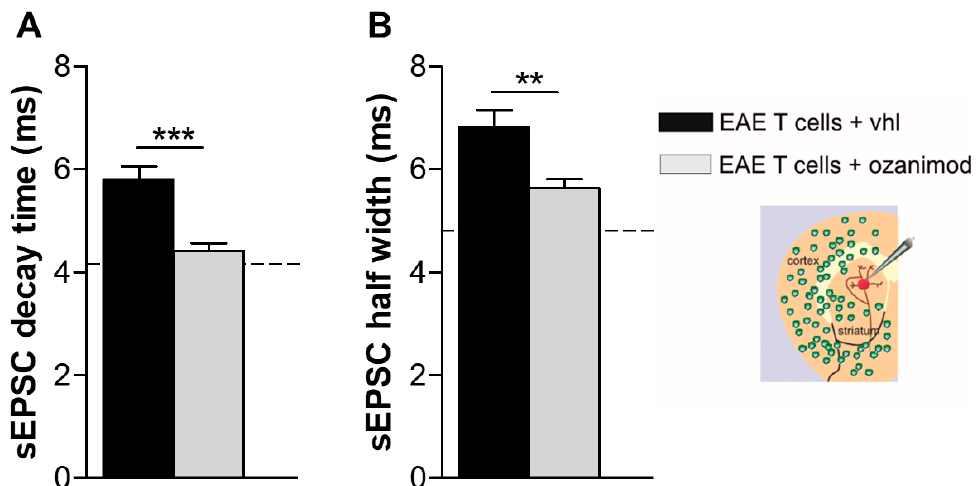
Figure 5. In vitro treatment of EAE T cells with ozanimod abolishes T cell synaptotoxicity. ( A , B ) The enhancement of sEPSC decay time ( A ) and sEPSC half width ( B ),typically induced by EAE lymphocytes, was significantly reduced by in vitro treatment of EAE T cells with ozanimod (1000 nM). Dotted lines refer to control condition (control T cells). Data are presented as ± SEM. Unpaired t -test, ** p < 0.01; *** p < 0.001.